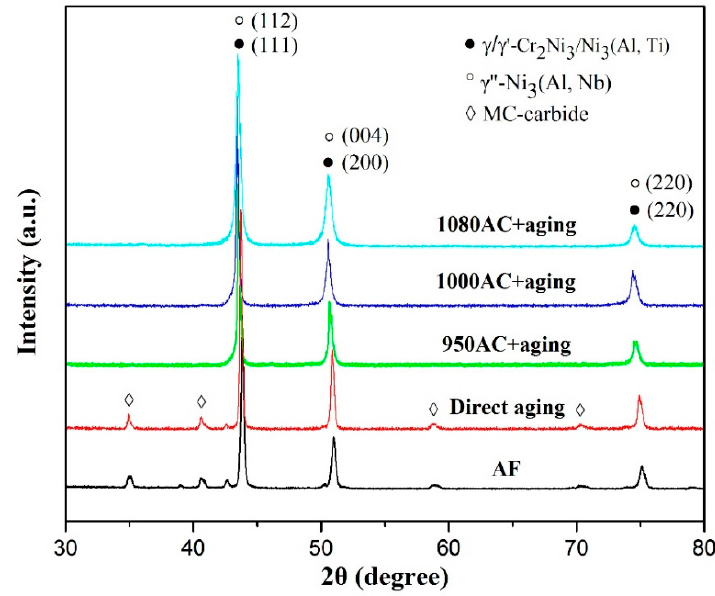
Figure 5. The X-ray diffraction (XRD) patterns of as-fabricated and heat-treated IN718